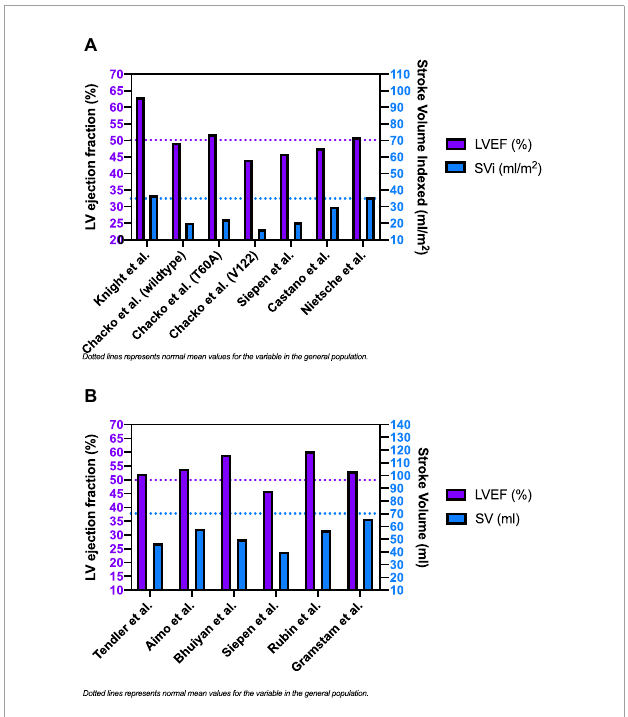
FIGURE3 Baseline left ventricular ejection fraction, stroke volume index [panel (A) ] and stroke volume [panel (B) ] in patients with cardiac